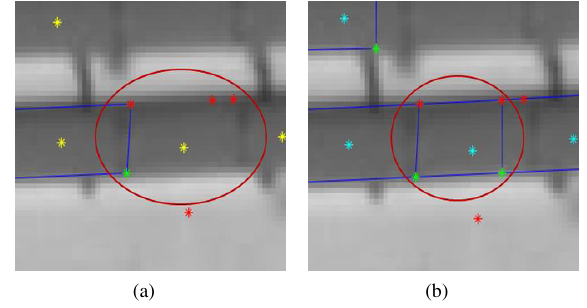
Figure 5. Iterative process case 3: a) two corners have been de- tected and one Förstner point exists as possible corner. Possible centre points marked in yellow. b) newly added rectangle for the two existing corners, the Förstner point and the newly generated virtual corner point with verified centre point (blue).